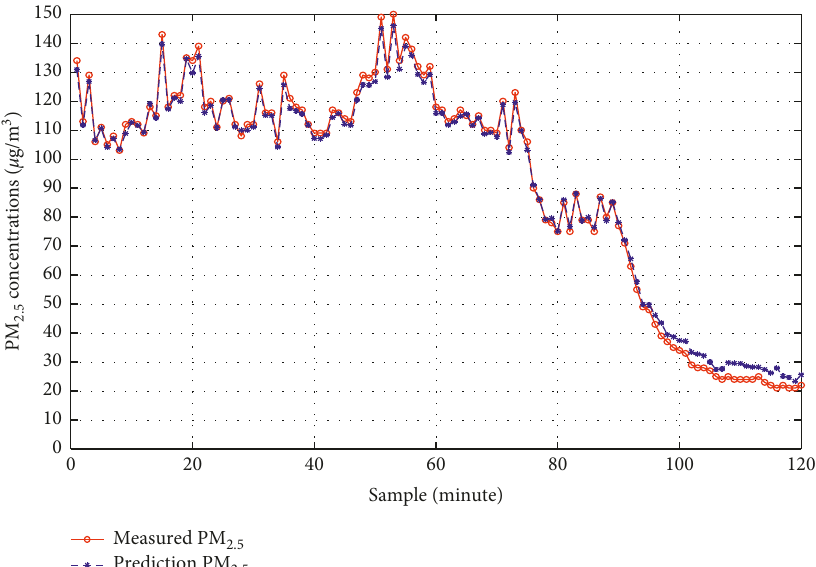
Figure 10: PM 2.5 concentration prediction result of model 6